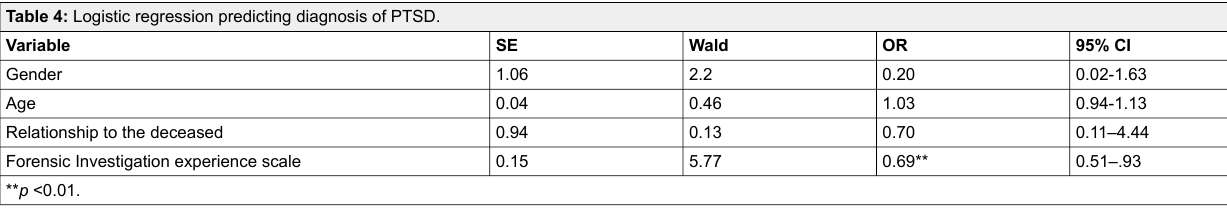
Table 4: Logistic regression predicting diagnosis of PTSD.